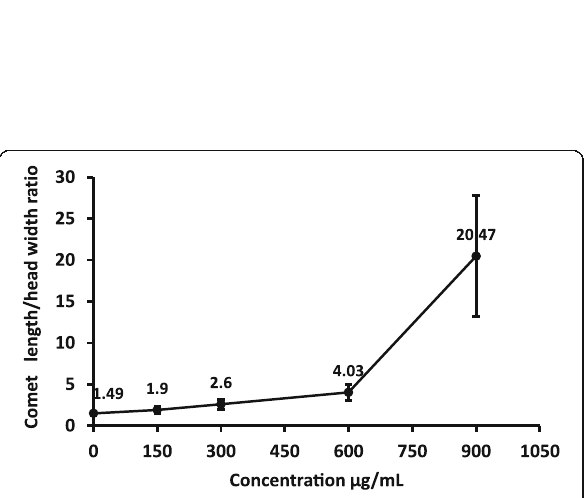
Fig. 8 The ratio of comet length to head width (M ± SD; n = 50) of HEp-2 cells treated with Semecarpus parvifolia Thw.at different concentrations